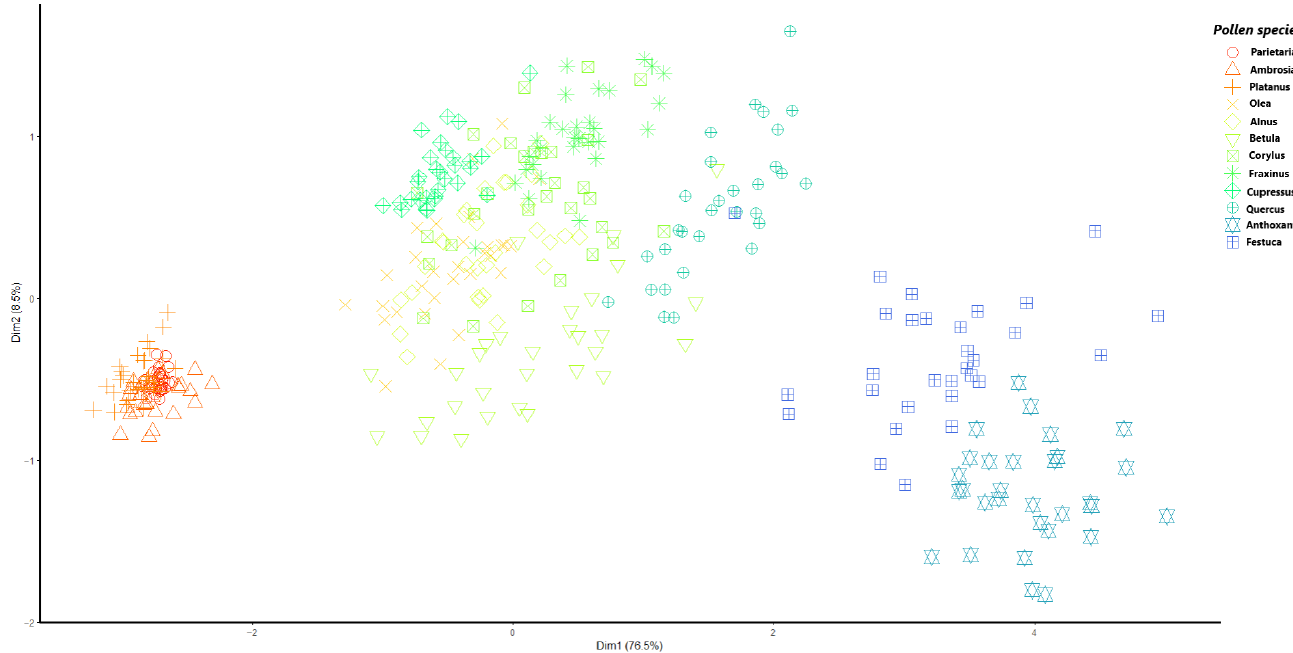
Figure 6. Dimensionality reduction of the pollen size information as provided by Beenose: the optical signatures are projected on their two principal axes, as obtained by PCA. Three groups can be distinguished: small size pollens (left), medium size pollens (middle), and pollens with the largest diameters (right).